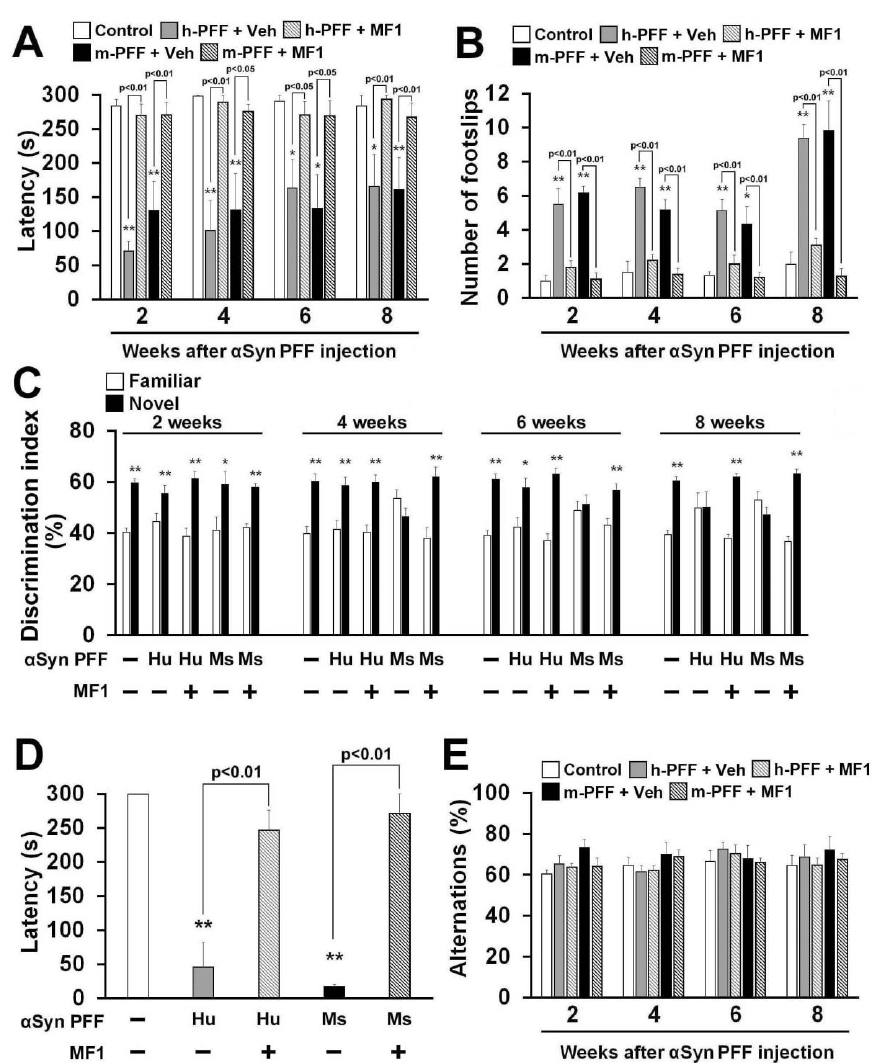
Figure 6. The FABP3 inhibitor MF1 attenuates behavioral deficits in human and mouse α -Syn PFF-injected mice. ( A, B ) Investigation of motor function based on the rotarod task ( A ) and beam walking task (B) at 2, 4, 6, and 8 weeks after human or mouse α -Syn PFF injection (control: n = 6; vehicle-treated human α -Syn PFF injection: n = 8; MF1-treated human α -Syn PFF injection: n = 10; vehicle-treated mouse α -Syn PFF injection: n = 6; MF1-treated mouse α -Syn PFF injection: n = 10). Error bars represent SEM. * p < 0.05, ** p < 0.01 vs. control mice. ( C ) Cognitive function was analyzed using the novel object recognition task among all groups at 2, 4, 6, and 8 weeks after α -Syn PFF injection (control: n = 6; vehicle-treated human α -Syn PFF injection: n = 8; MF1-treated human α -Syn PFF injection: n = 10; vehicle-treated mouse α -Syn PFF injection: n = 6; MF1-treated mouse α -Syn PFF injection: n = 10). Error bars represent SEM. * p < 0.05, ** p < 0.01 vs. familiar object. ( D ) Treatment with MF1 significantly antagonized the decreased retention time in human and mouse α -Syn PFF injected mice (control: n = 6; vehicle-treated human α -Syn PFF injection: n = 8; MF1-treated human α -Syn PFF injection: n = 10; vehicle-treated mouse α -Syn PFF injection: n = 6; MF1-treated mouse α -Syn PFF injection: n = 10). Error bars represent SEM. ** p < 0.01 vs. control mice. ( E ) There was no di ff erence observed in alternation behaviors among groups (control: n = 6; vehicle-treated human α -Syn PFF injection: n = 8; MF1-treated human α -Syn PFF injection: n = 10; vehicle-treated mouse α -Syn PFF injection: n = 6; MF1-treated mouse α -Syn PFF injection: n = 10). Error bars represent SEM. h-PFF: human α -Syn PFF injection, Hu: human, m-PFF: mouse α -Syn PFF injection, Ms: mouse, Veh: